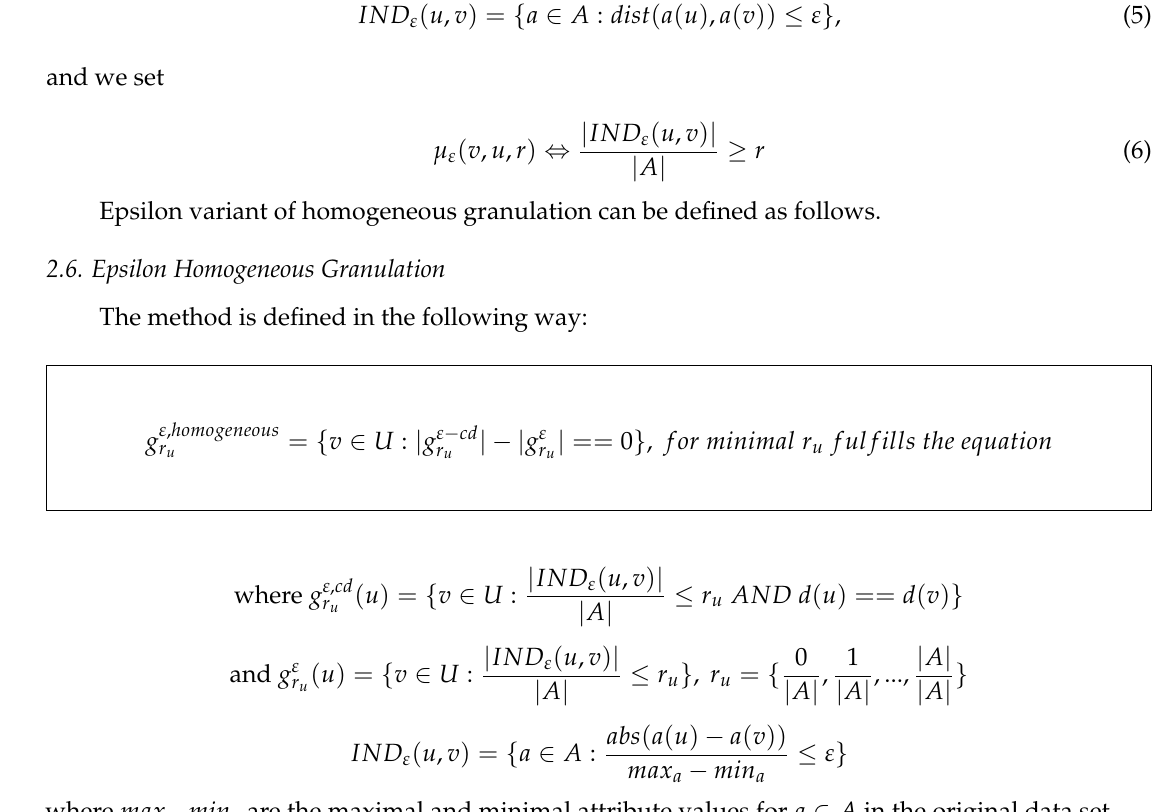
, A , d ) , temp 1 = MV ( g cd 3